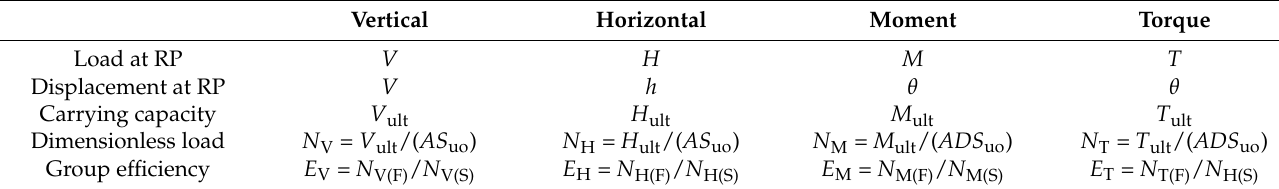
Table 1. Summary of notation for loads and displacement.